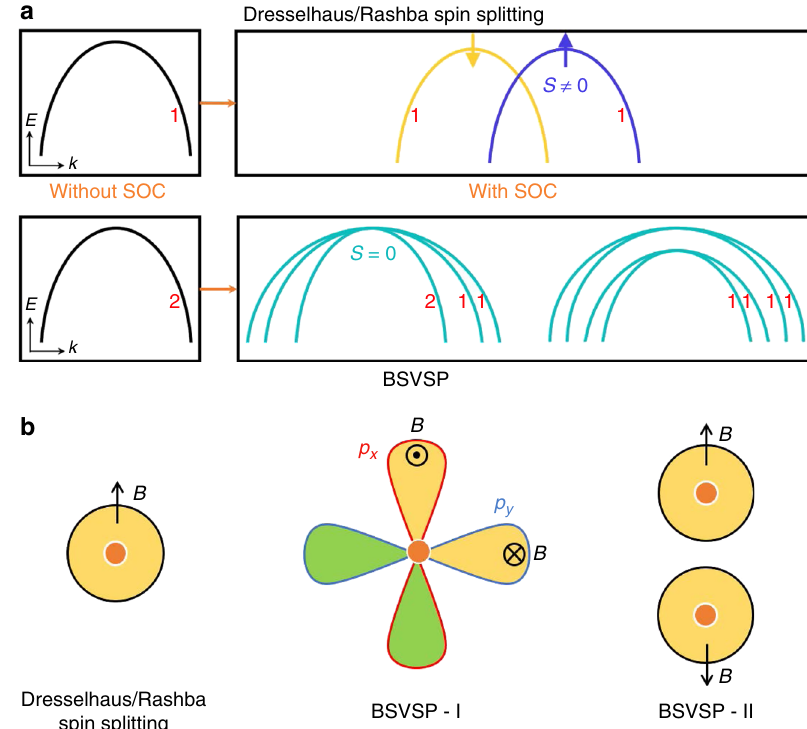
Fig. 1 The phenomena and mechanisms of Dresselhaus/Rashba spin splitting and BSVSP. a Schematic depiction of Dresselhaus/Rashba spin splitting and BSVSP. “ 1 ” and “ 2 ” means single and double degenerate, respectively. In the Dresselhaus/Rashba spin splitting case, a non-degenerate band (without considering spin) splits into two bands with opposite nonzero spin polarizations. In the case of BSVSP, a double degenerate band (without considering spin) splits, resulting in some non-degenerate bands without net spin polarizations (see Supplementary Note 1 for more discussions). b Schematic illustration of the difference between Dresselhaus/Rashba spin splitting and BSVSP. In the case of Dresselhaus/Rashba spin splitting, a k-dependent magnetic fi eld induces the band splitting. In BSVSP – I (II), the magnetic fi elds acting on two different p orbitals of the same atom (acting on different atoms of the same kind) are equal in strength but opposite, resulting in a band splitting with vanishing spin